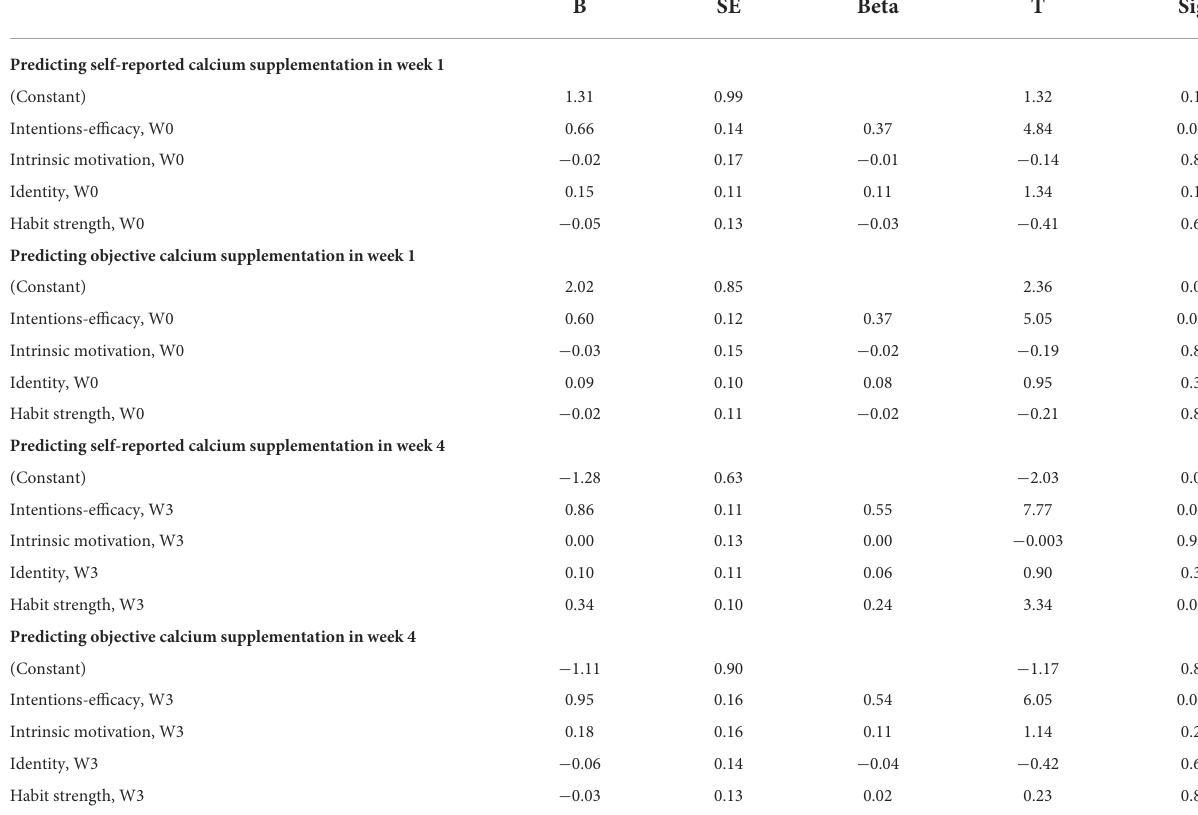
TABLE 2A Regression results for calcium supplementation variables (weeks 1 and 4 outcomes only, for comparison and space